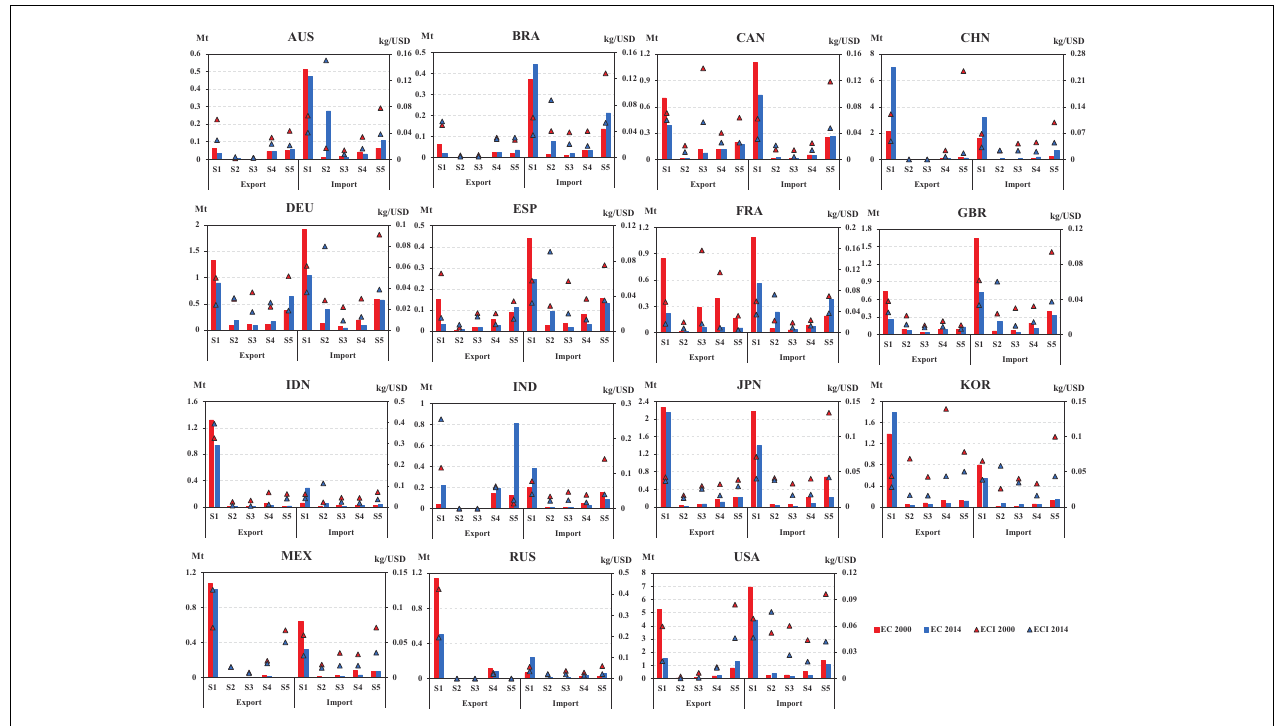
FIGURE 5 | The embodied carbon emissions and intensities of the ICT sectors in each country in 2000 and 2014. Note: EC represents the embodied carbon emissions, ECI represents the embodied carbon emission intensities.